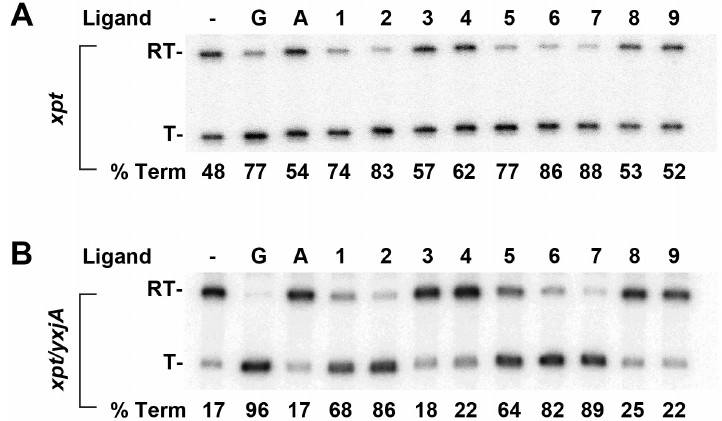
Figure 5. Single-turnover transcription assays using select guanine analogs. ( A ) Transcription termination assays using the wild type B. subtilis xpt-pbuX guanine riboswitch. The 32 P-labeled RNA bands in the denaturing polyacrylamide gel are denoted as “RT” for read-through full length RNA and “T” for terminated RNA. As an “OFF” switch, the guanine riboswitch terminates transcription in the presence of 20 µ M guanine (compare the no ligand ( − ) and guanine (G) lanes); the % termination product is given below each lane. All the reactions (except the no ligand control) have a 20 µ M compound. Lanes: ( − ), no ligand; G, guanine; A, adenine; 1, 8-aminoguanine; 2, O 6-methylguanine; 3, O 6-benzylguanine; 4, NU2058; 5, N 2-acetylguanine; 6, N 2-phenoxyacetyl guanine; 7, N2-